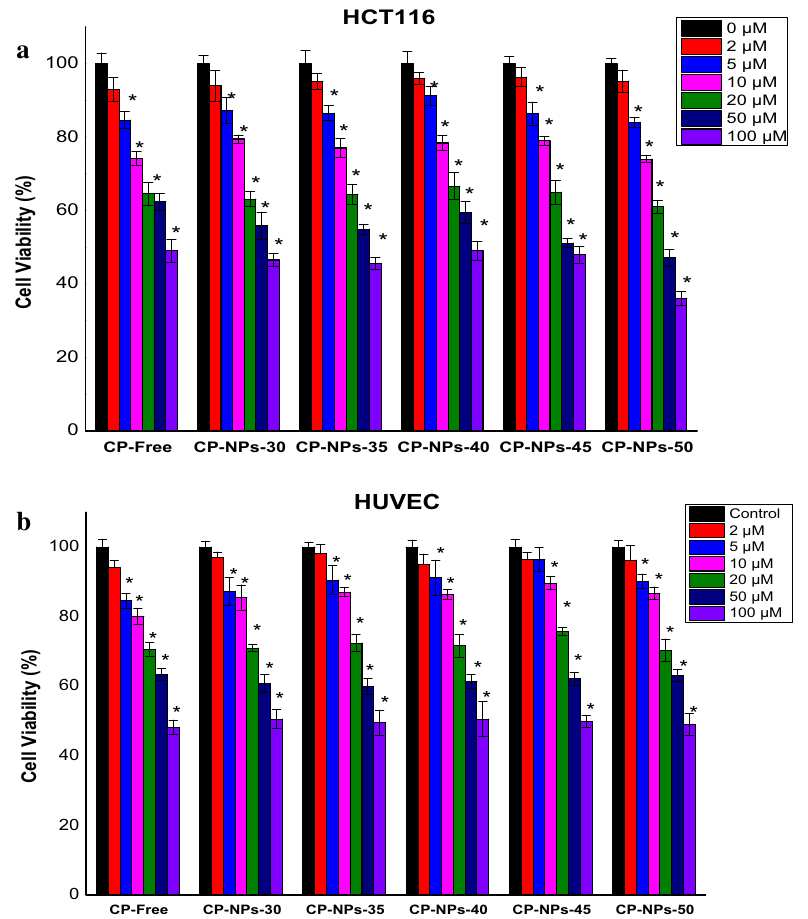
Figure 5. ( A ) The cell viability (%) of free CP and CP-NPs-30, CP-NPs-35, CP-NPs-40, CP-NPs-45, CP-NPs-50 compounds on HCT116 colon cancer cells. Data are shown as mean ± SD after 3 independent experiments. p-value was calculated according to control by Student’s t test using graph pad (* indicates p-values < 0.005). CP Carboplatin. ( B ) The cell viability (%) of free CP and CP-NPs-30, CP-NPs-35, CP-NPs-40, CP-NPs-45, CP-NPs-50 compounds on HUVEC normal cells. Data are shown as mean ± SD after 3 independent experiments. p-value was calculated according to control by Student’s t test using graph pad (* indicates p-values < 0.005). CP Carboplatin.